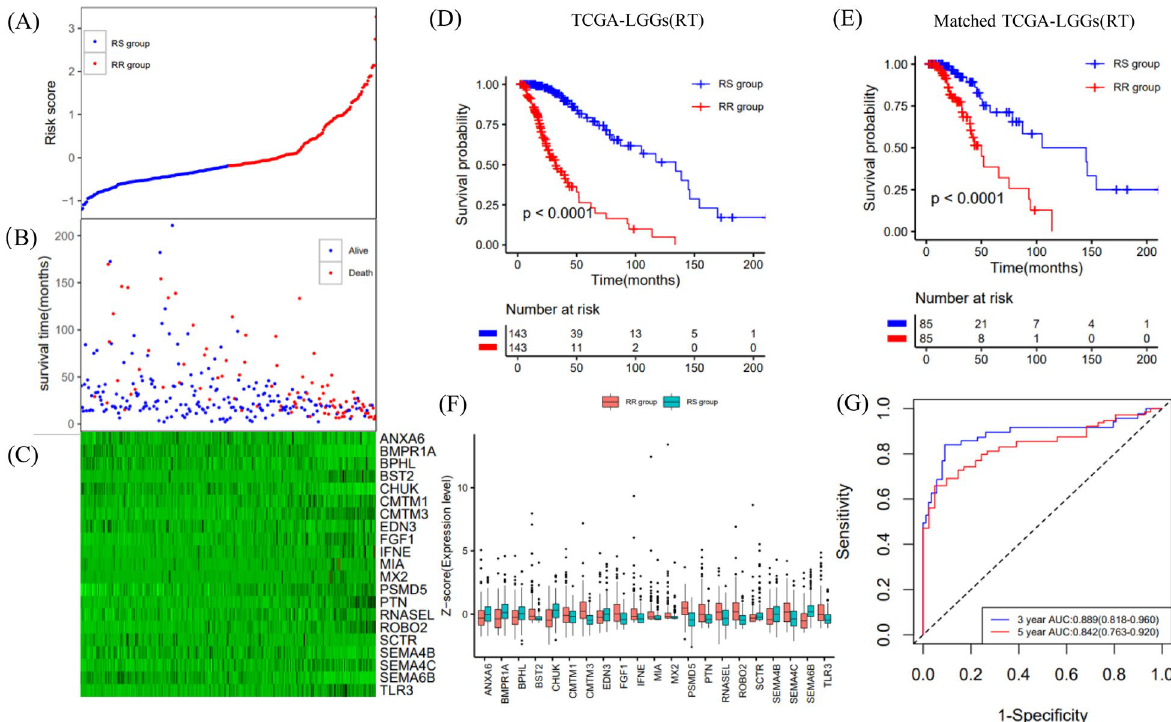
Figure 3. Construction of the OS prediction model based on 21 genes in the TCGA dataset. ( A , B ) The risk score, survival time of each sample. ( C ) Heatmap of 21 genes. ( D , E ) Survival curve of the RS group and RR group in radiotherapy patients in the unmatched and matched datasets. ( F ) The gene expression profile of the two groups of radiotherapy patients. ( G ) Time ‐ dependent ROC curve for